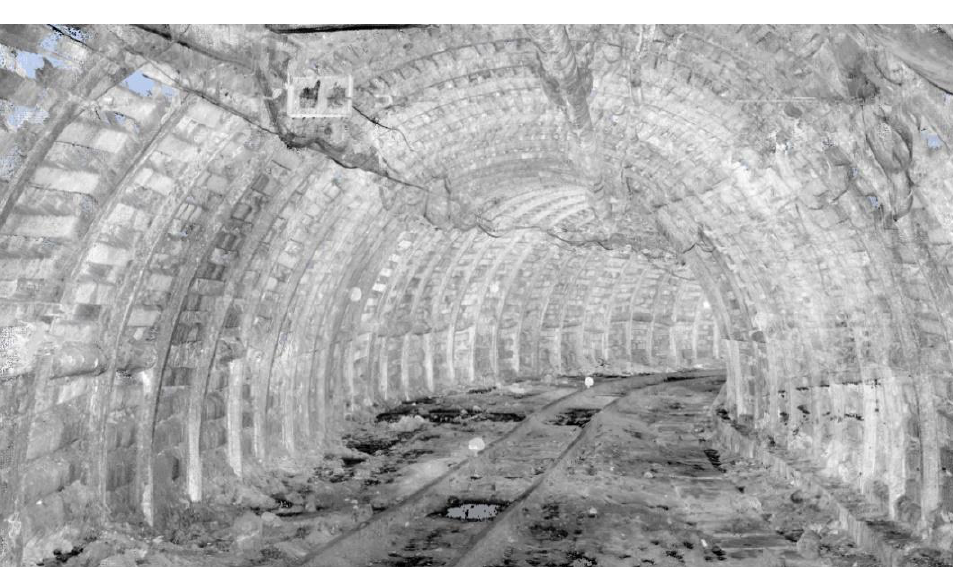
Figure 3. Point cloud view of the mine tunnel straight section near the bend.